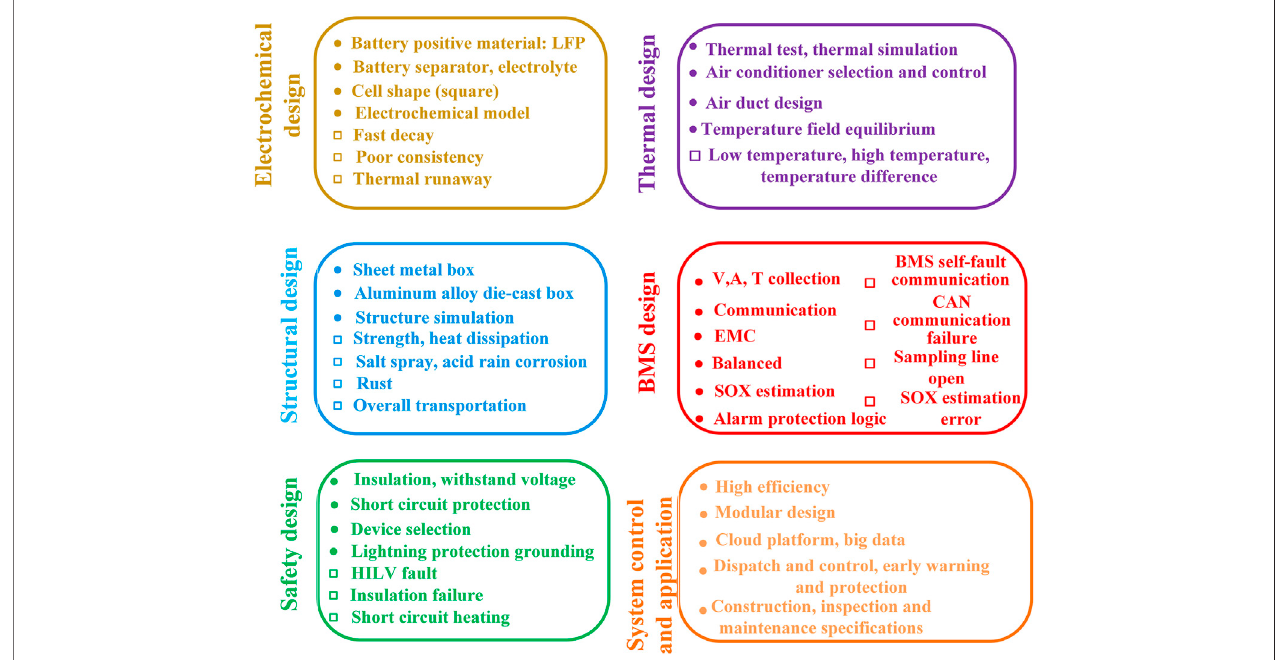
FIGURE 10 | Modularized design framework of cabin-type energy storage.